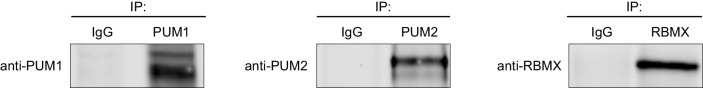
Representative western blots of PUM1, PUM2, and RBMX in RIP experiments.PUM1 migrates as a doublet in HCT116, possibly indicating post-translational modification or alternative splicing. We have confirmed that both bands represent PUM1 protein using siRNA knockdown experiments (data not shown).